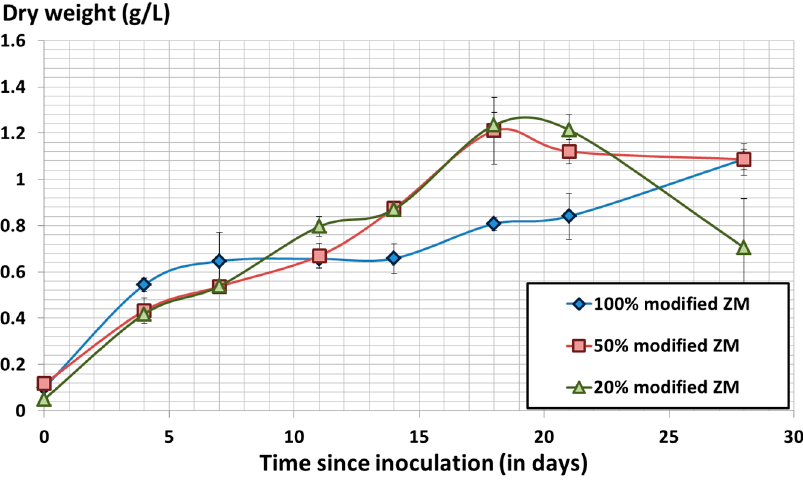
Figure 4. Dry weights of Spirulina grown in 100% (blue diamonds), 50% (red squares), and 20% (green triangles) modified ZM, triplicates. Error bars are standard deviations of the biological triplicates.